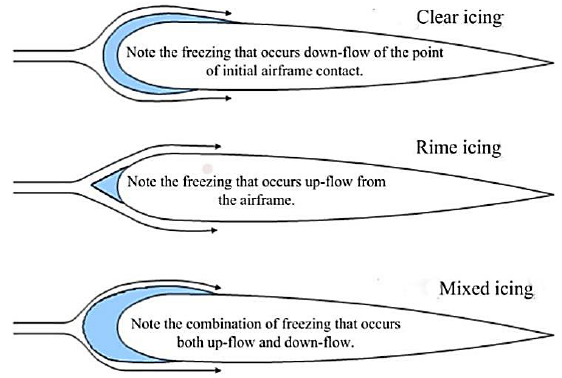
Figure 2. Three typical types of aircraft icing. Table 1. Aircraft icing level classification.